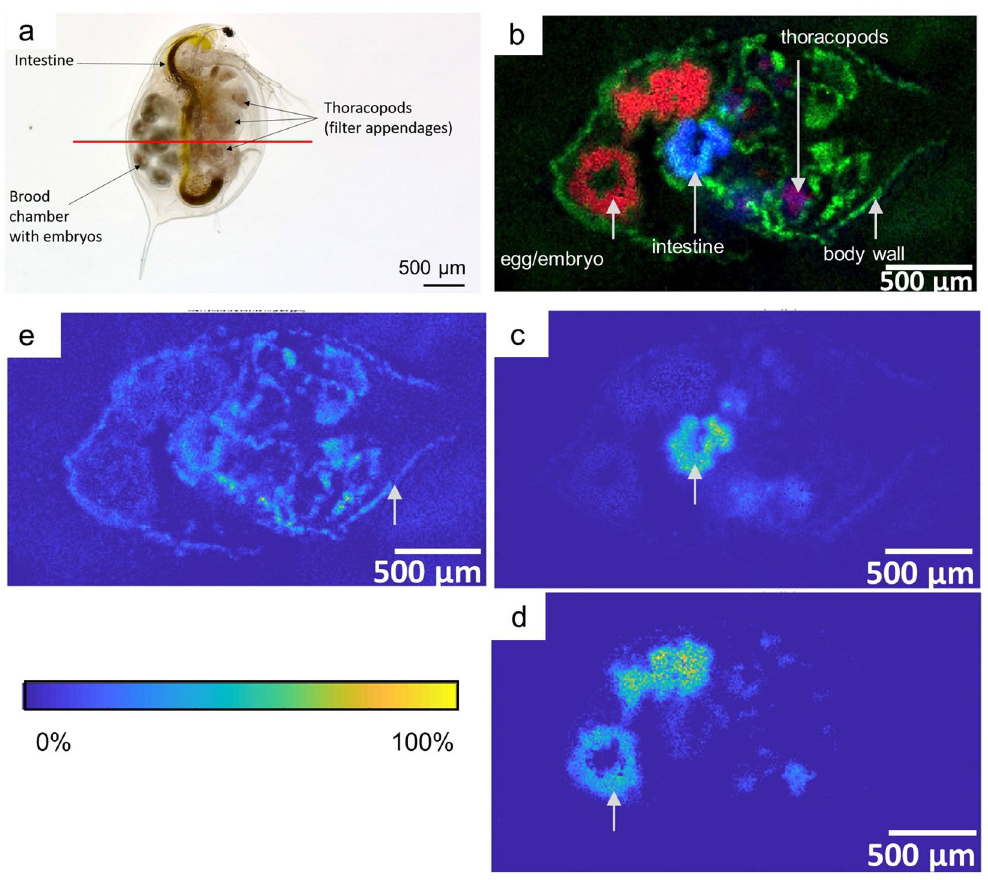
Figure 4. MALDI MSI visualizing the lipid distribution in D. magna . ( a ) Whole body image of D. magna . ( b ) RGB Overlay of PC (36:0) [M+Na] + (blue colored), HexCer (41:1;O 2 ) [M+2Na-H] + (red colored) and SM (38:1;O 2 ) [M+Na] + (green colored) visualizing different anatomical regions (thoracic legs, egg/embryo, intestine, body wall). ( b – d ) Positive ion MS images. ( c ) Ion image of PC (36:0) [M+Na] + , highlighting the intestine region (labeled by a white arrow). ( d ) Ion image of HexCer (41:1;O 2 ) [M+2N-H] + , highlighting the lipid distribution within the egg/embryo (labeled by a white arrow). ( e ) Ion image of SM (38:1;O 2 ) [M+Na] + , showing the lipid distribution in the surrounding tissue including body wall (labeled by a white arrow) and thoracic